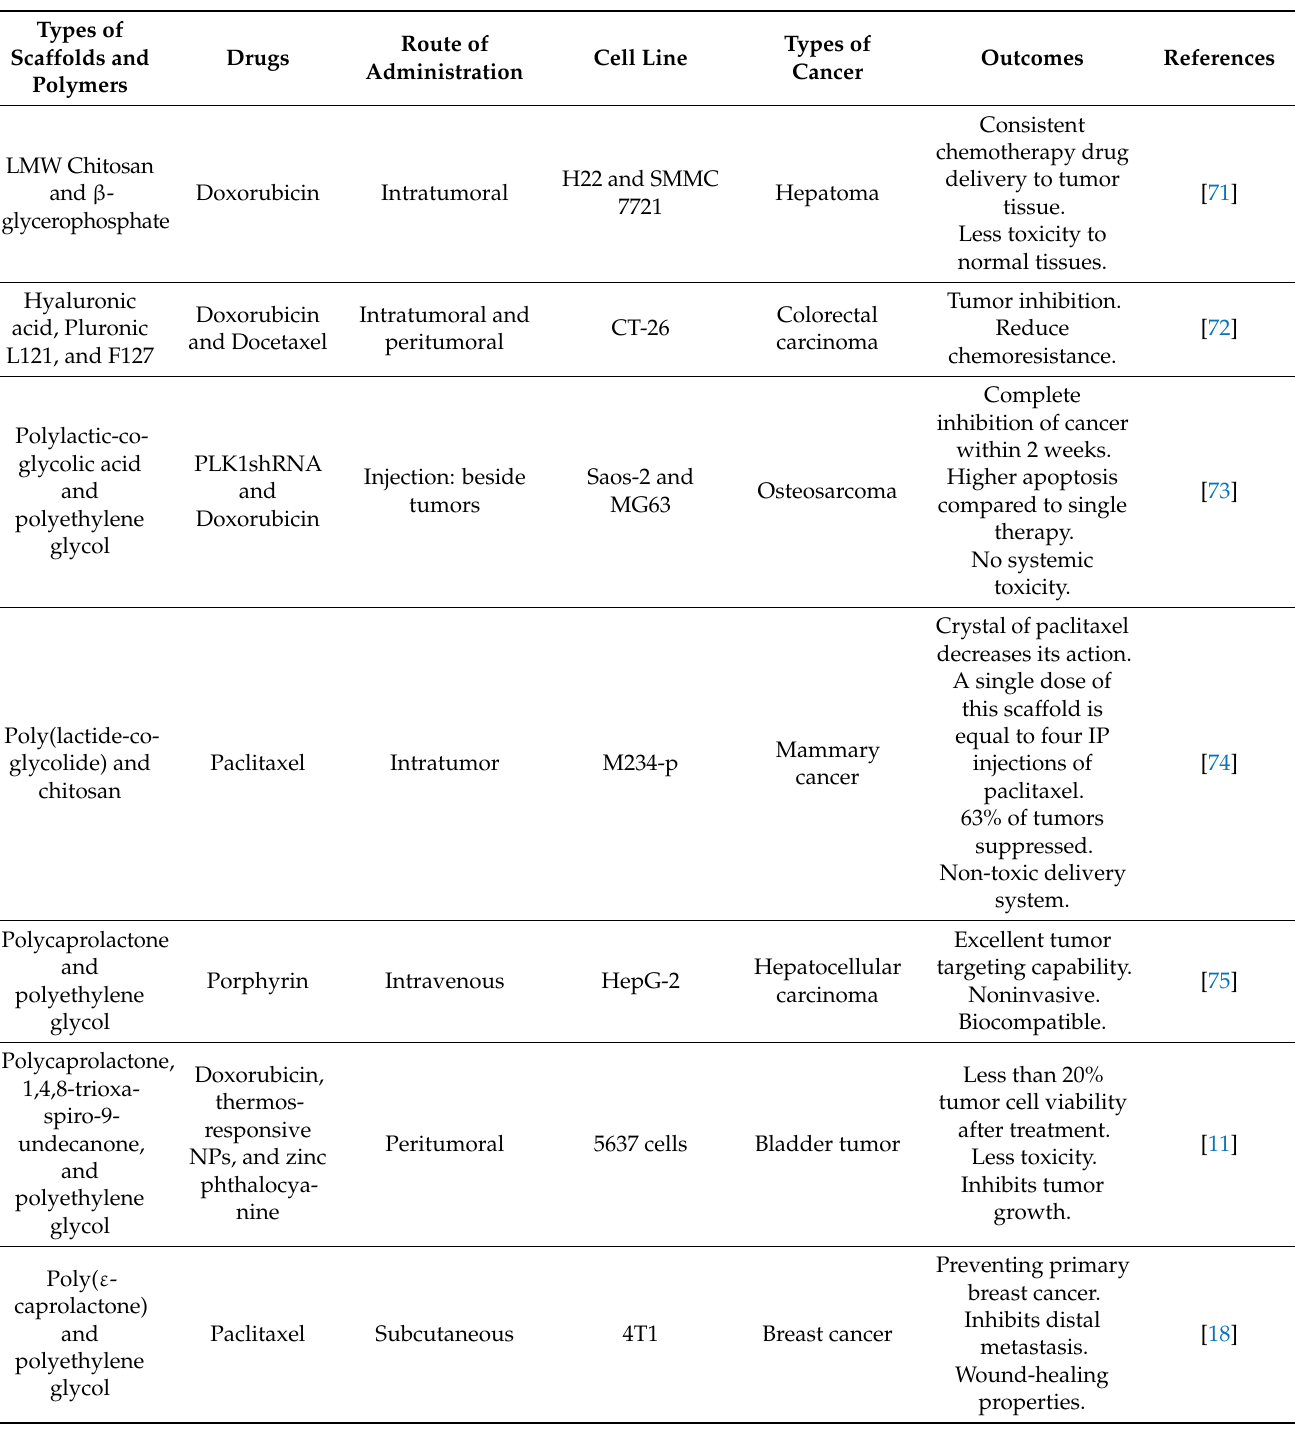
Table 3. Next-generation 3D Scaffolds and their therapeutics